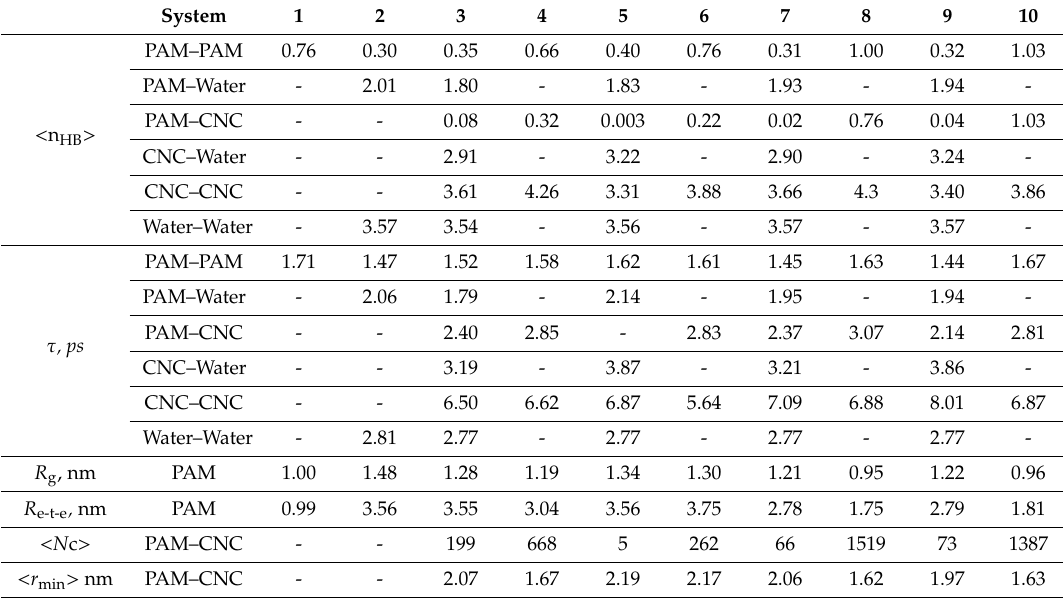
Table 2. The structural and dynamic characteristics obtained by analyzing the last 10 and 5 ns of the trajectories for water-contained and vacuum systems,